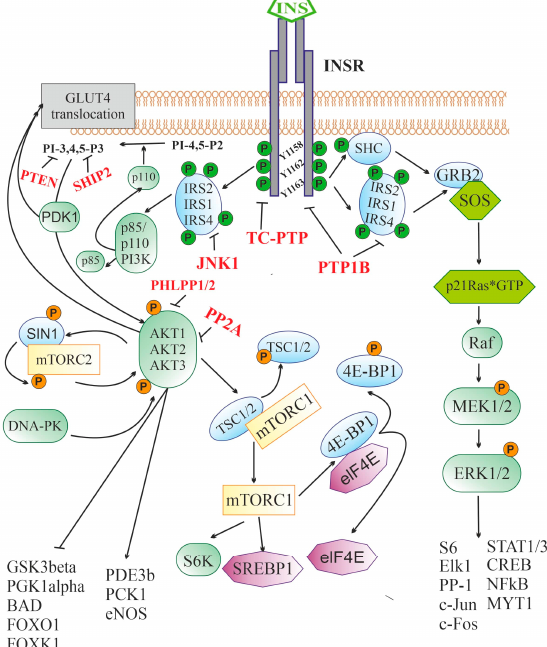
Figure 1. Insulin-activated signaling pathways. Abbreviations: INSR—insulin receptor, containing three sites for tyrosine phosphorylation (Y1158, Y1162, and Y1163); IRS1, IRS2, and IRS4—insulin receptor substrates-1, -2 and -4, respectively; p85 and p110 PI3K—p85-regulatory and p110-catalytic subunits of phosphatidylinositol-3-kinase; PI-4,5-P2—phosphatidylinositol-4,5-diphosphate; PI- 3,4,5-P3—phosphatidylinositol-3,4,5-triphosphate; PDK1—phosphoinositol-dependent protein kinase-1; AKT1, AKT2, and AKT3—serine/threonine-specific protein kinase B (AKT kinase) of the types 1, 2 and 3, respectively; DNA-PK—DNA-dependent protein kinase; mTORC2—mammalian